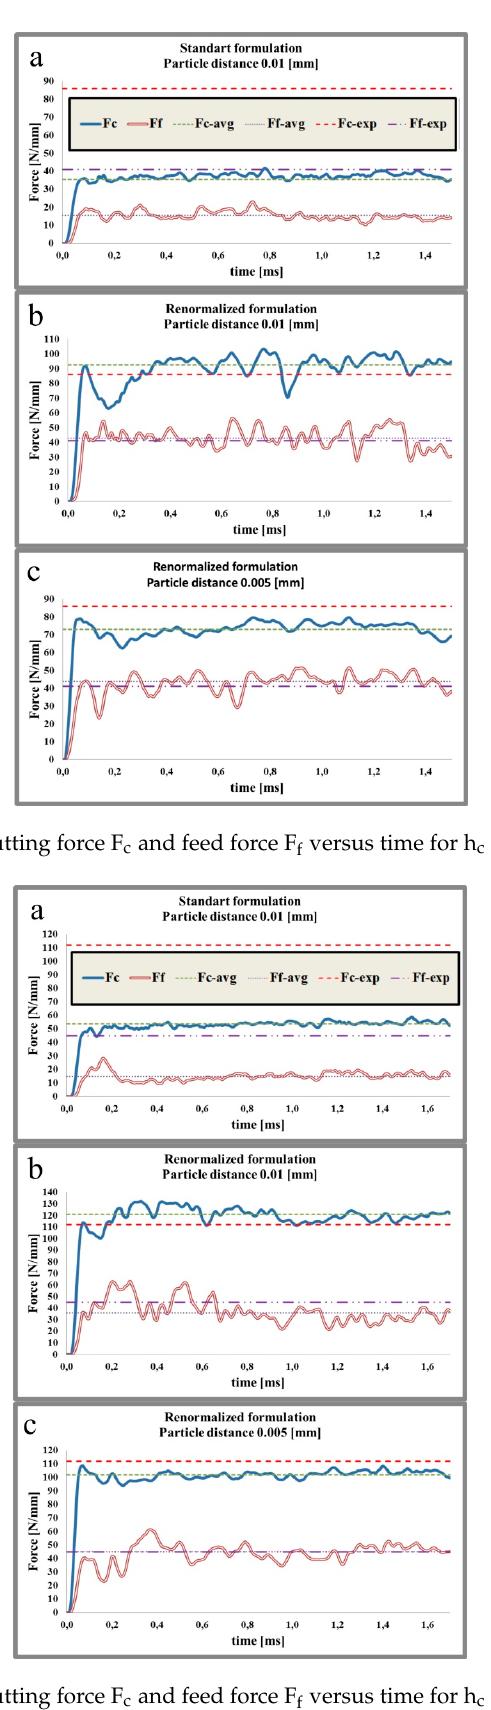
Figure 8. Cutting force F c and feed force F f versus time for h c = 0.06 mm.